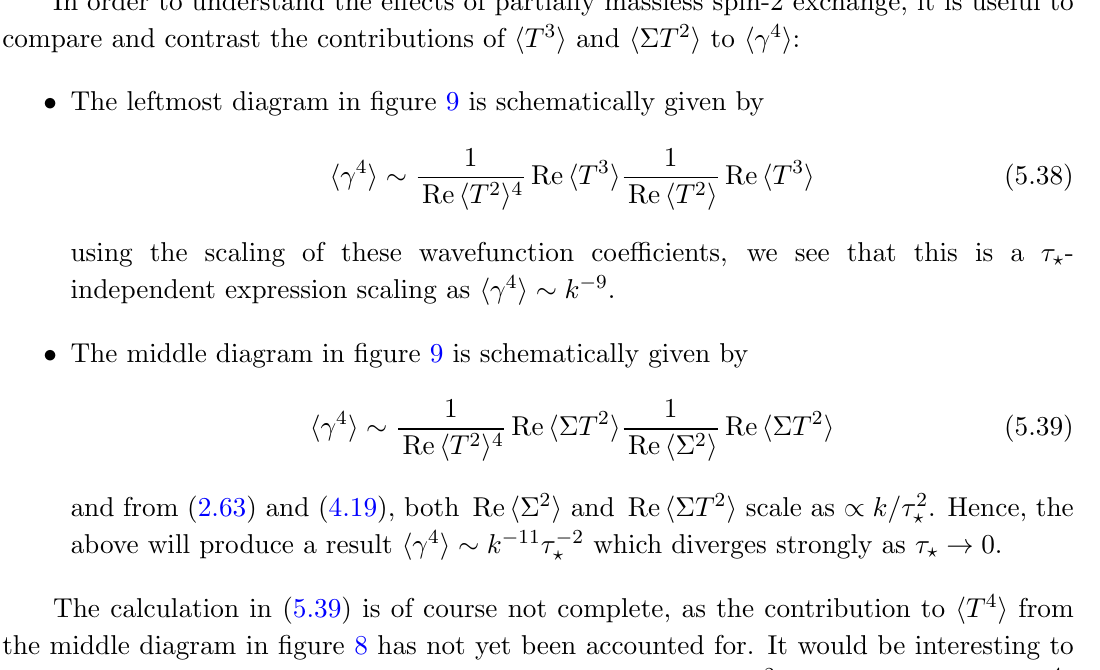
Figure 9 . Contributions to the graviton trispectrum fields. The three-point vertices come from the culated. The four-point vertex depends on the whose associated diagrams are shown in figure